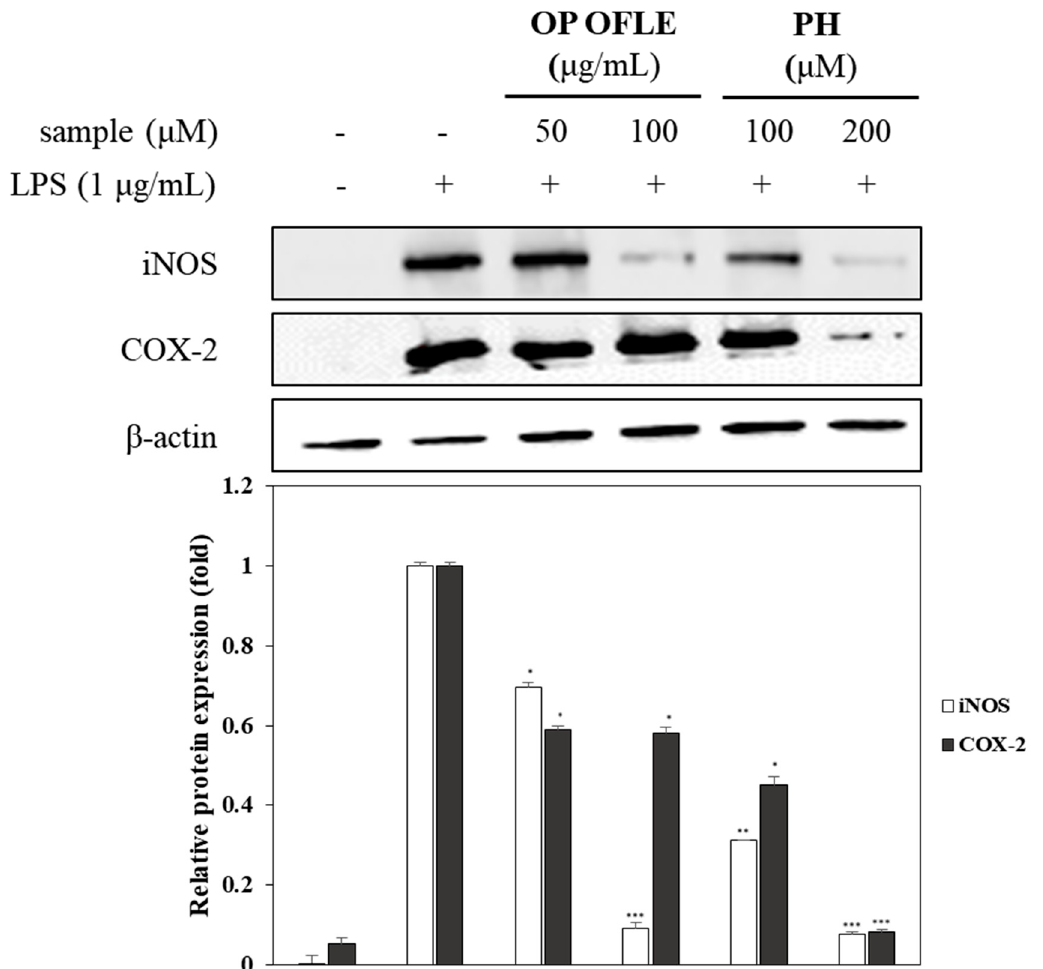
Figure 7. Effects of OP OFLE and PH on iNOS and COX-2 expression. RAW 264.7 cells were cultured in the presence of OP OFLE (50 and 100 μ g/mL) or PH (100 and 200 μ M) for 2 h and then induced with LPS (1 μ g/mL) for 20 h. Levels of iNOS, COX-2, and β -actin in the LPS-stimulated cells were evaluated by Western blot analysis. Relative density was calculated as the ratio of the expression level of each protein to that of β -actin. Data are expressed as mean ± SD ( n = 3) of three individual experiments. * p < 0.05, ** p < 0.01, *** p < 0.001 vs. LPS-stimulated group.